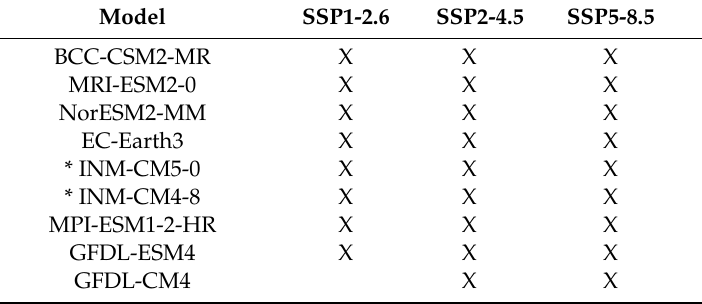
Table 2. List of global climate models (GCMs) considered in this